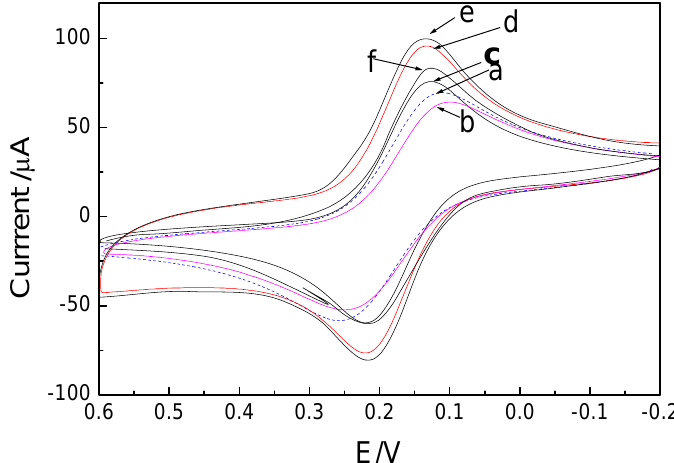
Figure 4. Cyclic voltammograms of the electrode at difference stages: (a) bare Au, (b) Au|MSA, (c) Au|MSA/{pLys/GMP-anti-p24}, (d) Au|MSA/{pLys-GMPs-anti-p24} (e)Au| MSA/{pLys-nanoAu-anti-p24} , (f) the immunosensor of (d) after incubated in the 3 solution containing 50 ng/mL p24 for 30 min at 37 ºC. Supporting electrolyte: 5 mmol/L Fe(CN) ) solution containing 0.1 mol/L KCl; scan rate: 100 mV/s. The bare FeCN(K 3 6 electrode curve (dashed line, n = 0) is shown for